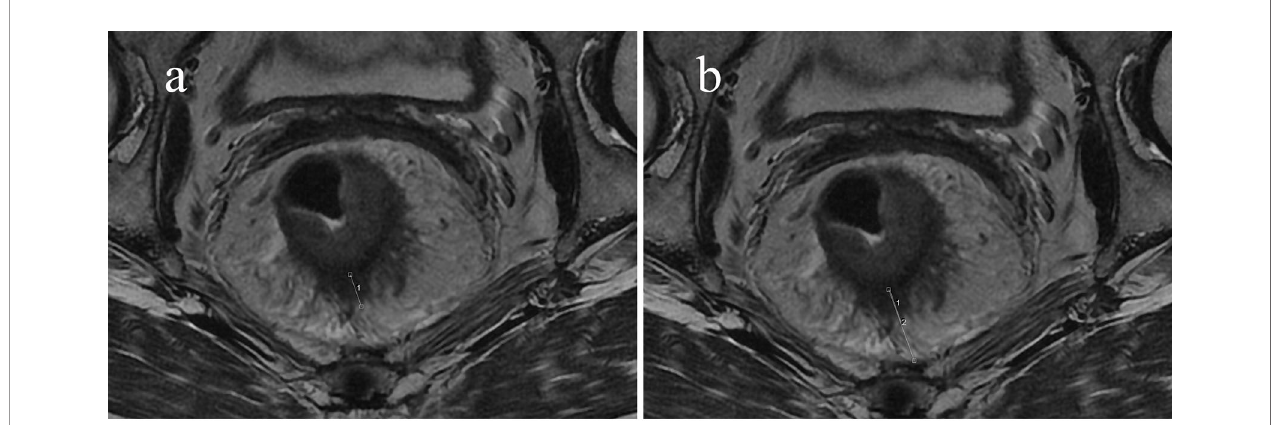
FIGURE 4 | Sixty-seven-year-old man with an mr-T3N0 rectal adenocarcinoma 9.5 cm from the anal verge. Pretreatment rectal MRI (A, B) before NCRT. The EMD was 9.7 mm (A) , the TM was 21.7 mm (B) , and the calculated PTI was 44.7%. The rectal cancer had regressed after NCRT. The postoperative staging con fi rmed by pathology was T0N0, and the tumor response was pCR.